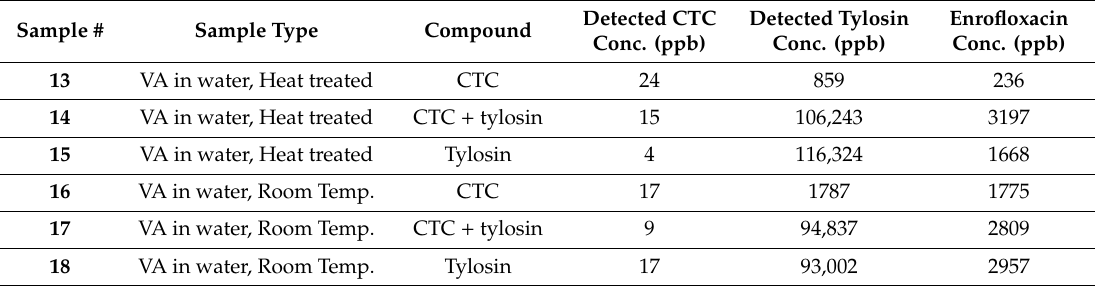
Table 7. Concentrations of VAs were detected in the water samples.